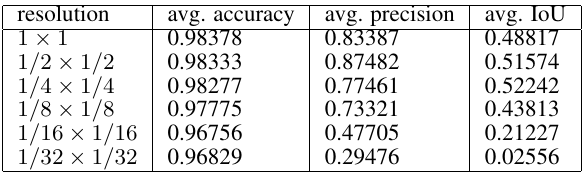
Table 2. Performance of door detection with Faster R-CNN on the ICG Graz50 dataset using different image